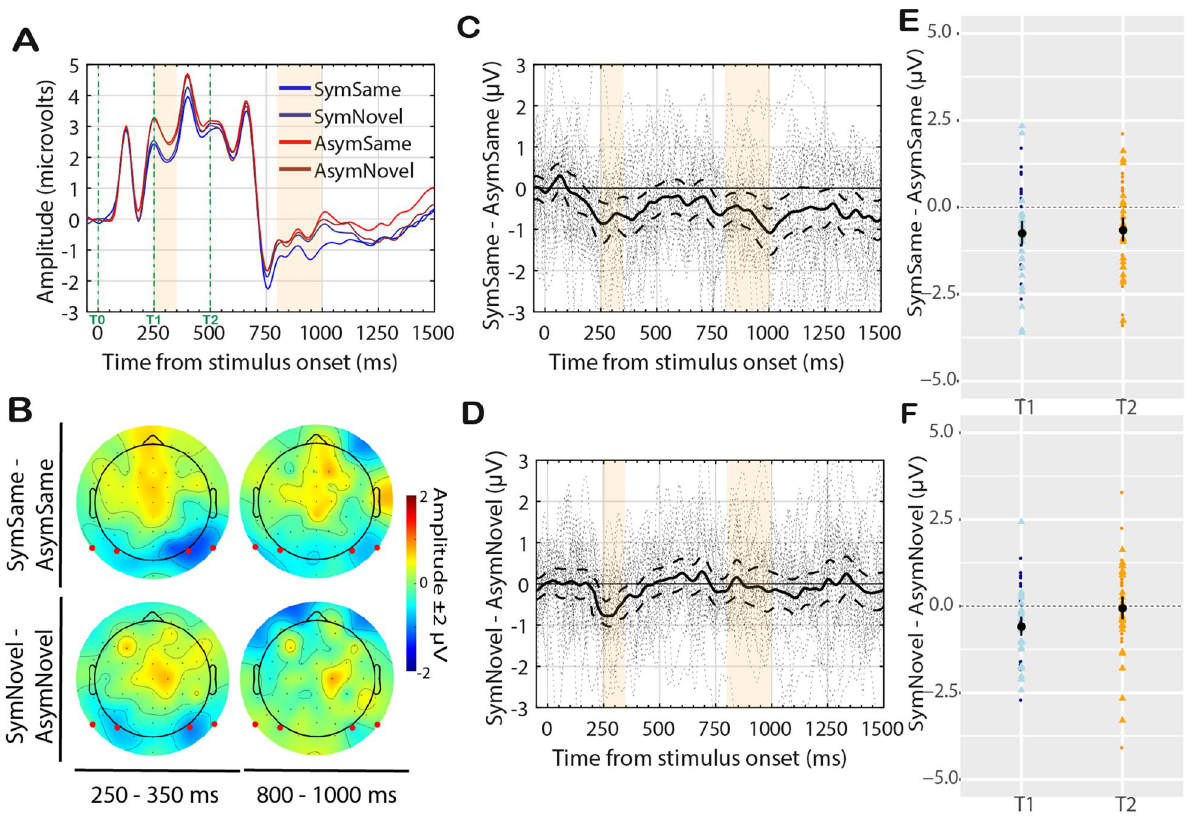
Figure 7. Experiment 3 Results. Conventions are the same as in Figs. 3 and 5.